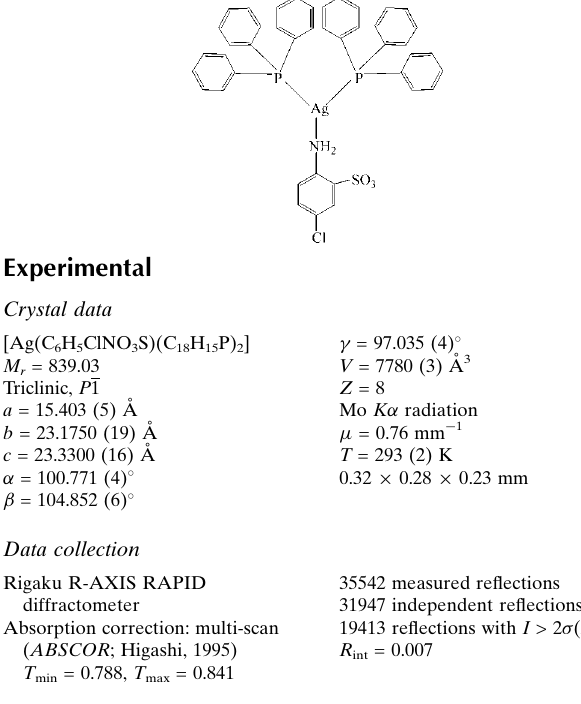
molecules. In each of the molecules, the Ag I cation is three- coordinated by two triphenylphosphine ligands, and one N atom from a 2-amino-5-chlorobenzenesulfonate anion. The molecules are linked into a one-dimensional supramolecular